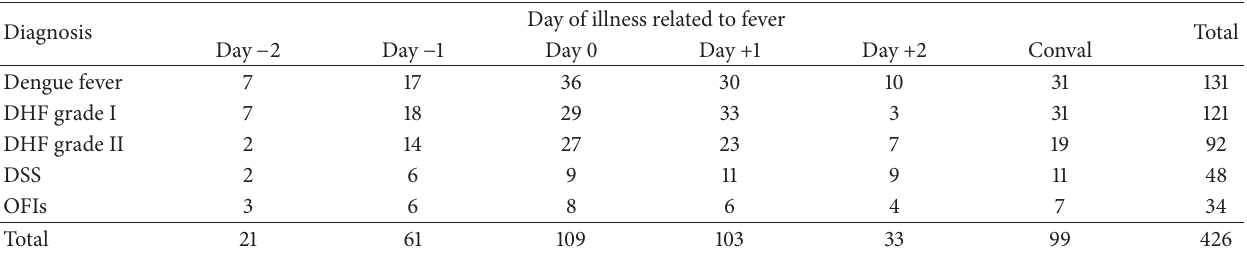
Table 2: The distribution of studied samples followed by the day of illness related to fever. Diagnosis